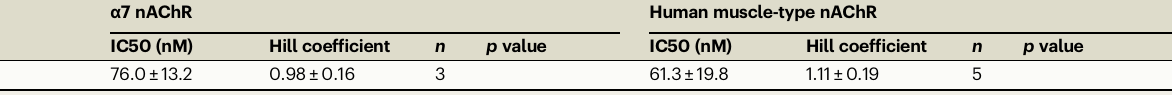
Table 2 | IC50 values and Hill coef fi cients for wild-type ScNtx and mutants on the neuronal α 7 nAChR and the muscle- type